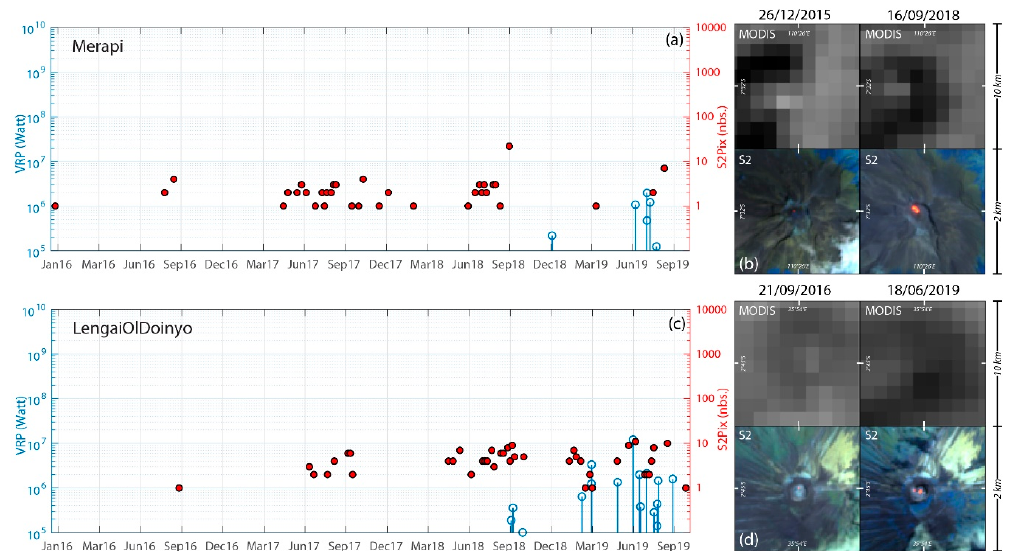
Figure 13. SENTINEL-2 and MIROVA thermal comparison. Case studies of Merapi and Ol Doinyo Lengai. In ( a , c ), logarithmic timeseries. With blue stem on left y-axis, MIROVA VRP heat flux in Watt, with red dots on right y-axis S2Pix. In ( b , c ), composition images, particulars of NTI–MODIS zoomed maps from MIROVA (see [25]) are reported on top side, SENTINEL-2 MSI RGB (12-11-8a bands analysis) zooms are reported on the bottom side. The MODIS and SENTINEL-2 MSI images are taken in the same day acquisition and with the closest timing (hours or minutes) available between the acquisitions.